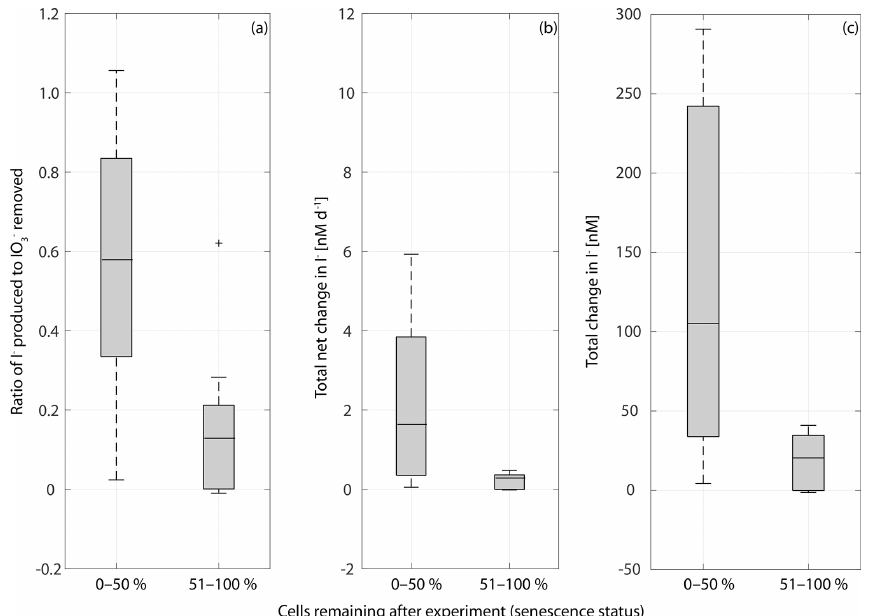
Figure 9. Box plot of the ratio of I − produced to IO − removed in cultures of a range of marine phytoplankton at different stages of senescence 3 in (a) , net rate of change in iodine over the whole length of the experiment (b) and the total change in iodide at the end of each experiment (c) . Senescence status is defined as the percentage of the maximum cell number remaining at the end of the experiment: 0%–50% indicates that there are 0%–50% of cells remaining indicating late senescence, and a senescence status of 51%–100% indicates that there are 51%–100% of cells remaining indicating early senescence. Ratios are significantly different between the 0%–50% and 51%–100% groups (Wilcoxon rank sum test: p = 0 . 014, n = 30), as is the total net iodine change ( p = 0 . 005, n = 30) and the total change in iodide ( p = 0 . 006, n = 30).